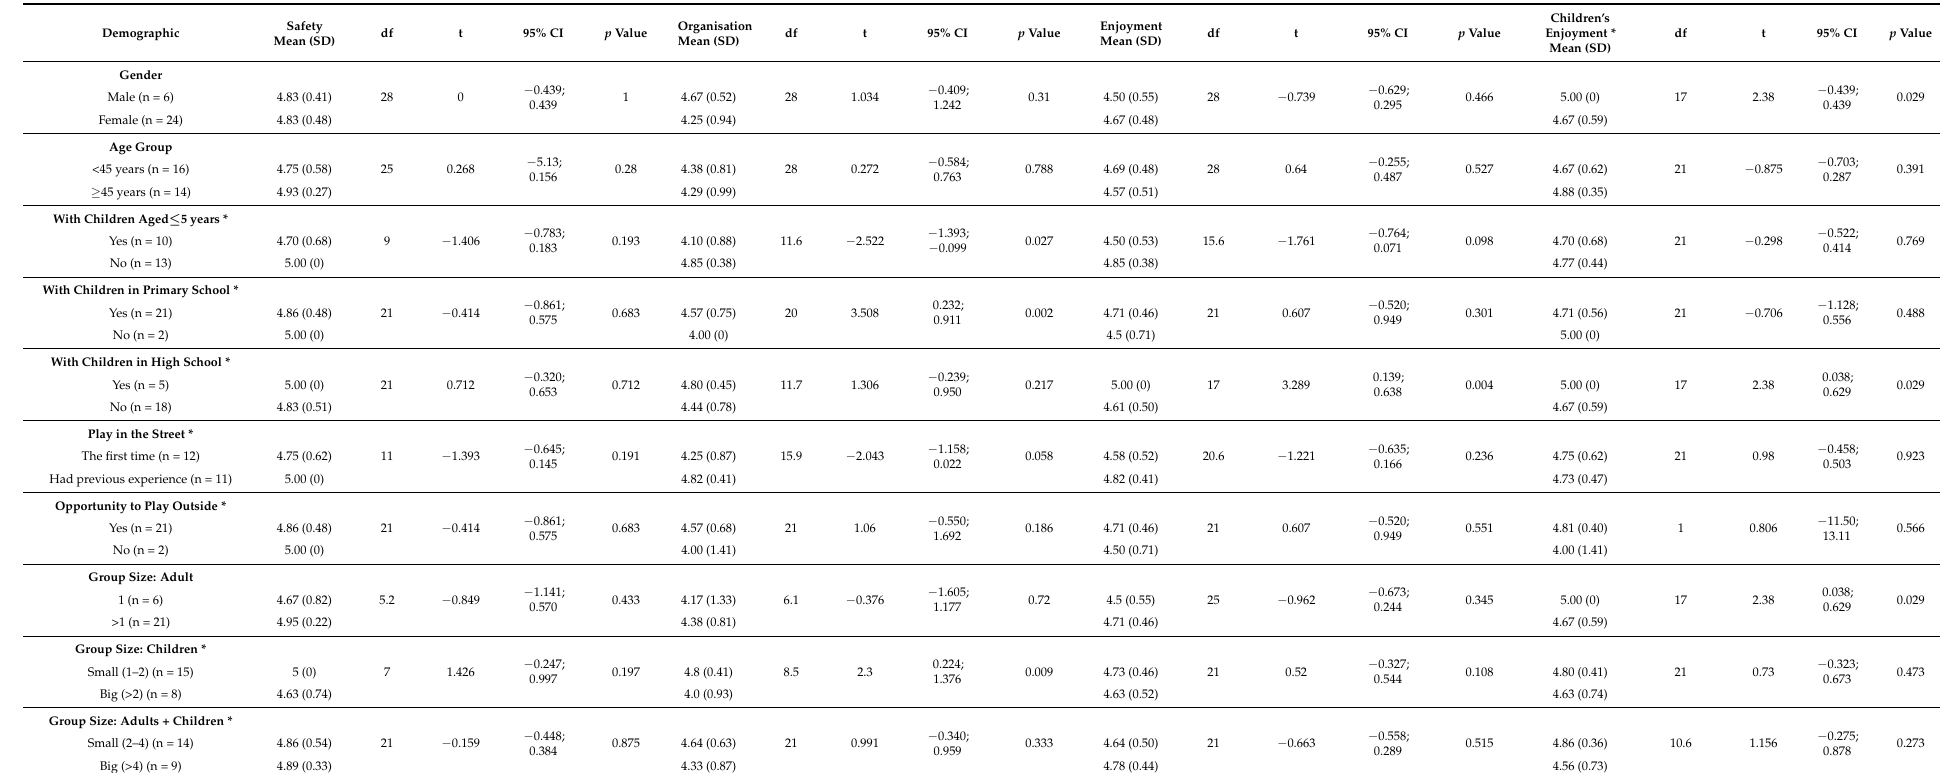
Table 2. Perceptions of pilot Play Street by demographic characteristics (n = 30) #